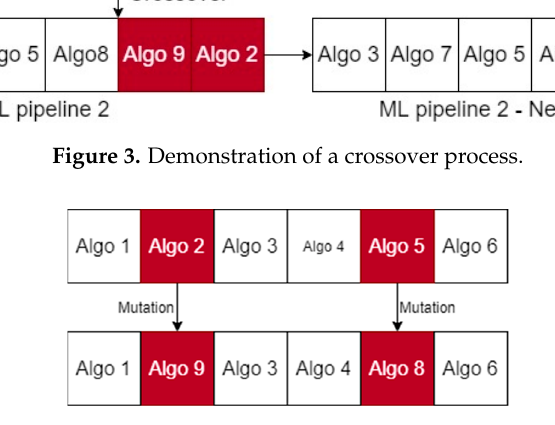
Figure 4. Demonstration of a mutation process.